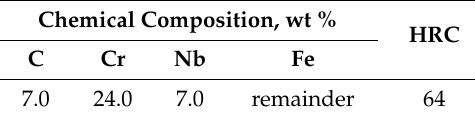
Table 5. Chemical composition of the layer formed by GMA (Gas Metal Active) with a ceramo-metallic wire layer.